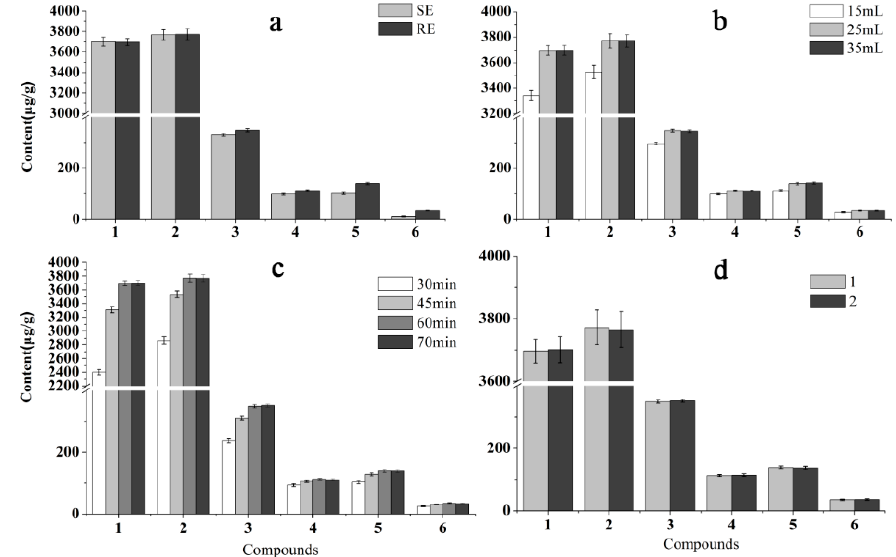
Figure 3. Effects of ( a ) method (SE, sonication extraction; RE, refluxing extraction); ( b ) solvent volume; ( c ) extraction time; and ( d ) extraction repetition on the extraction efficiency of target analytes in S13 M . officinalis sample from Hainan province.